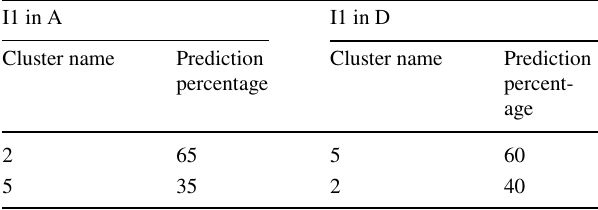
Table 10 Frequencies data of I1 in A and I1 in D